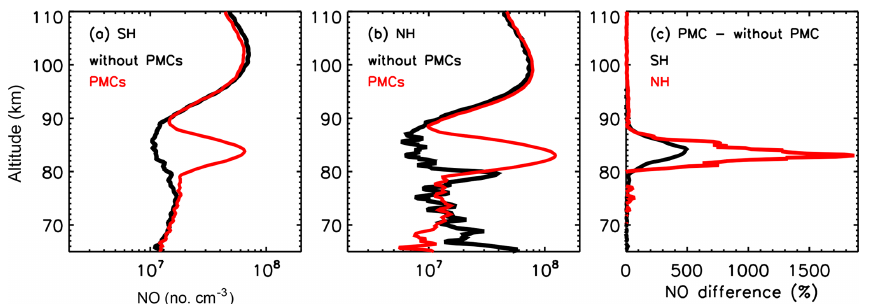
Figure 3. Comparison of average NO profiles during polar summer ( − 30 to 60d from solstice, during 2007 to 2013) with and without PMCs present, for the (a) SH and (b) NH. (c) Difference in average NO ND for the profiles with and without PMCs, for both hemispheres.